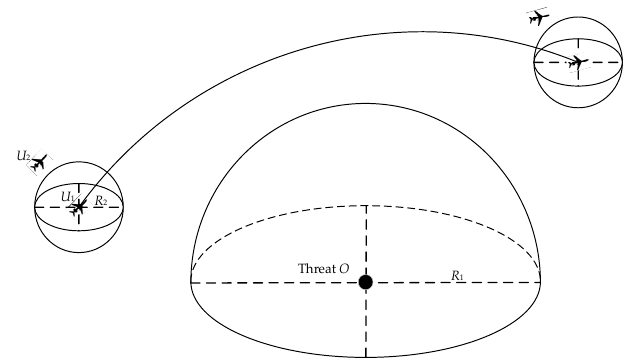
Figure 3. Cooperative obstacle avoidance model.